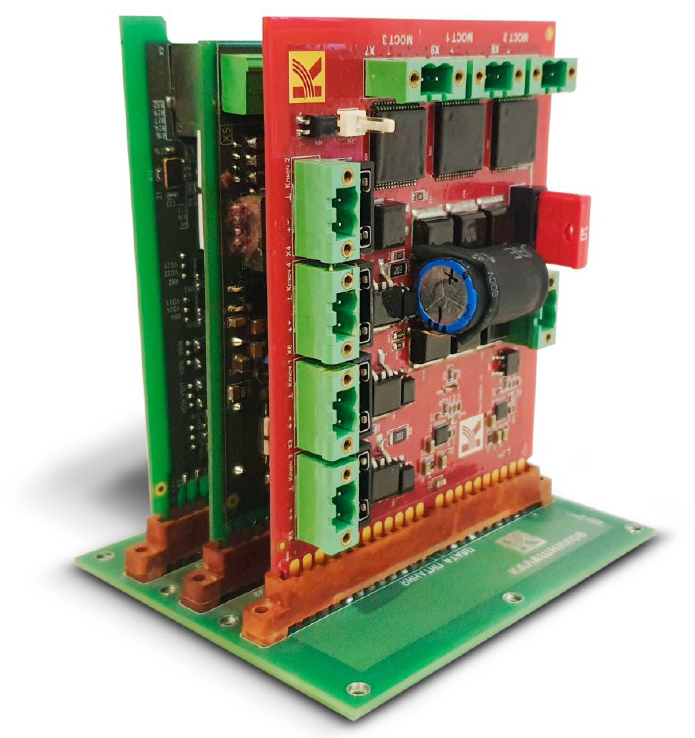
Figure 10. The control computing unit for the robots Quadruped, RGSS.